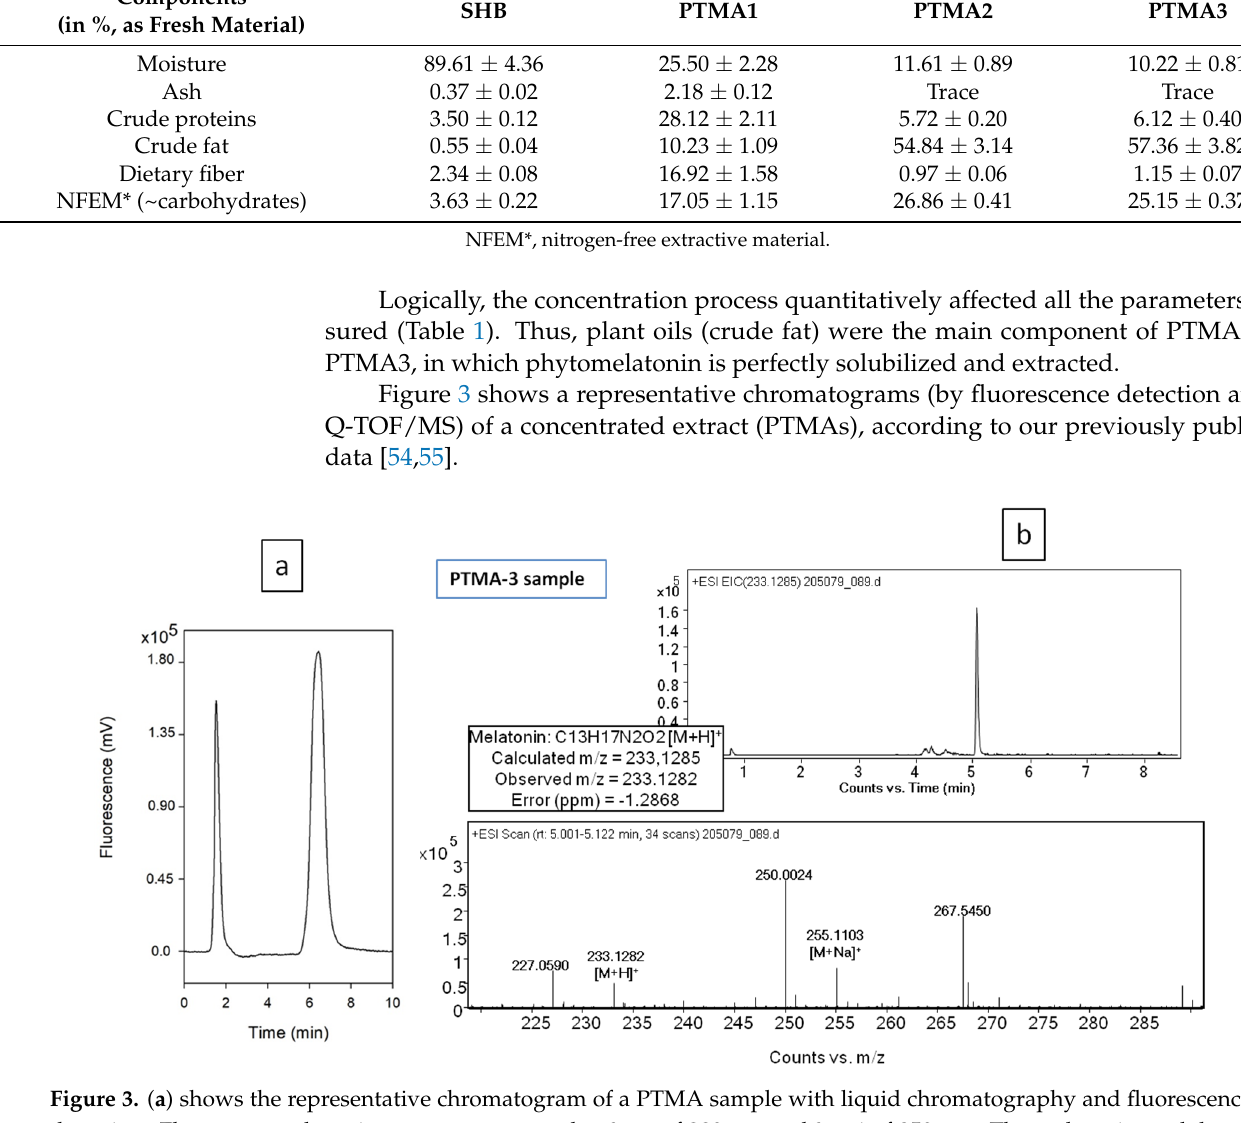
Figure 3. ( a ) shows the representative chromatogram of a PTMA sample with liquid chromatography and fluorescence detection. Fluorescence detection was programmed at λ exc of 280 nm and λ emi of 350 nm. The melatonin peak has a retention time of 6.5 min. ( b ) shows the representative chromatogram and mass spectra of PTMA3 sample using liquid